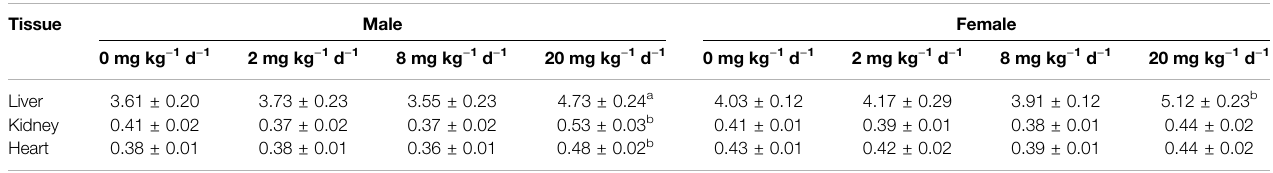
TABLE 2 | Tissue somatic indices of rats following oral administration of ATO for 28 days. Tissue